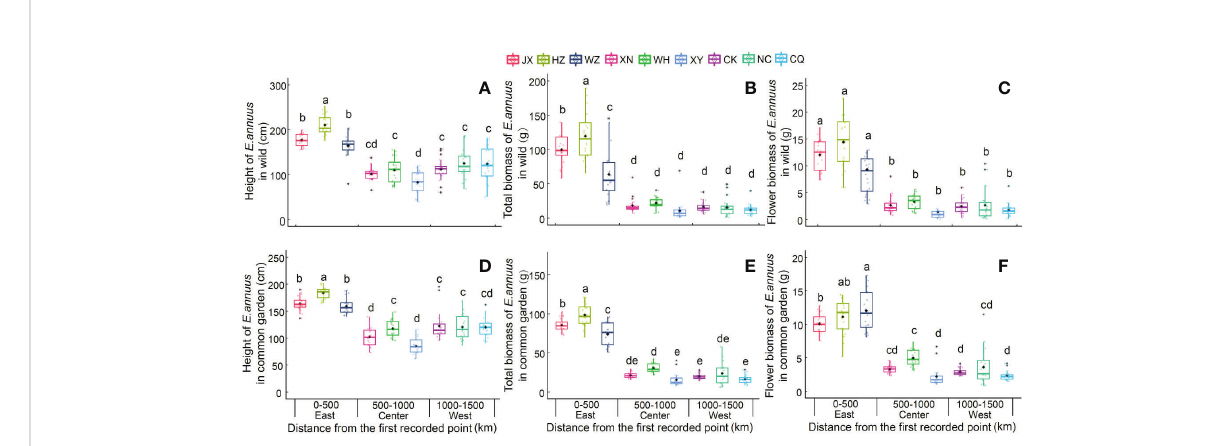
FIGURE 1 Height (A, D) , total biomass (B, E) and fl ower biomass (C, F) of E. annuus geographic populations in different regions in wild and common garden experiments. Mean ± SE were given. Different lowercase letters mean statistically signi fi cant differences (P < 0.05) JX, Jiaxing; HZ,